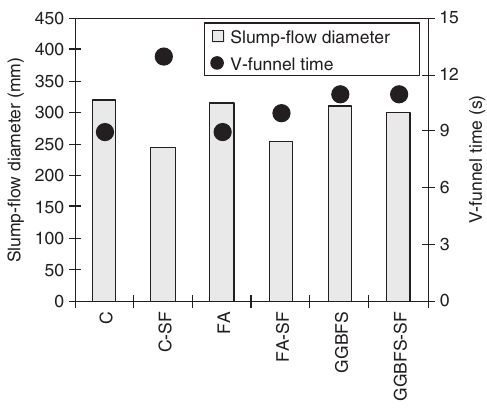
Figure 2 Mini V-funnel and slump-flow test